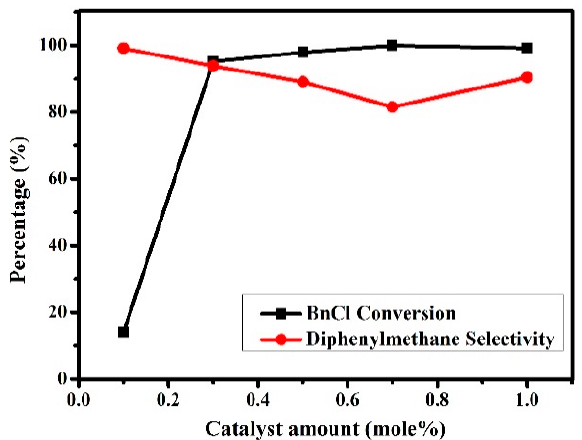
Figure 2. The effects of the amount of catalyst on the Friedel–Crafts alkylation reaction of p-xylene with BnCl (at a reaction temperature of 80 °C, a reaction time = 0.5 h, and a molar ratio of p-xylene: BnCl = 2:1).